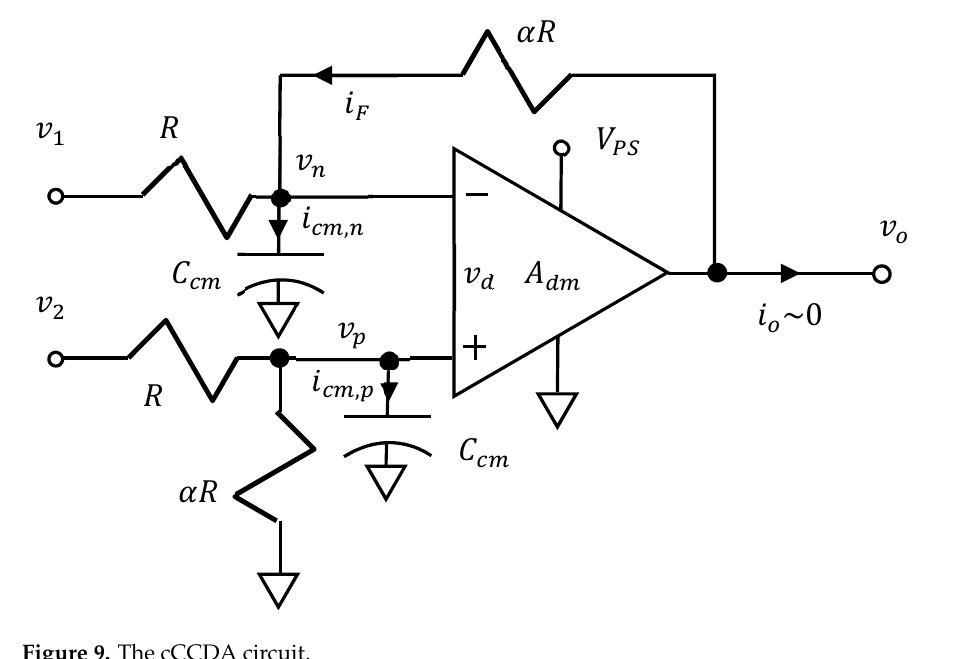
11 of 25 Figure 8. Response of a dCCDA with large resistance. 3.2. Common-Mode CCDA The common-mode CCDA (cCCDA), illustrated in Figure 9, consists of a standard arrangement of a difference amplifier and two capacitors added to the terminals. The ca- pacitors are referred to as common-mode capacitors. Assuming the operational amplifier has zero offset voltage, the output resistance is negligibly small, and the input resistance is much larger than 𝑅 , we obtain 𝑖 (cid:3030)(cid:3040),(cid:3043) = 𝑇 (cid:3030)(cid:3040) 𝑠 (1 + 𝛼 + 𝑇 (cid:3030)(cid:3040) 𝑠) 𝑣 (cid:2870) (𝑠) 𝑅